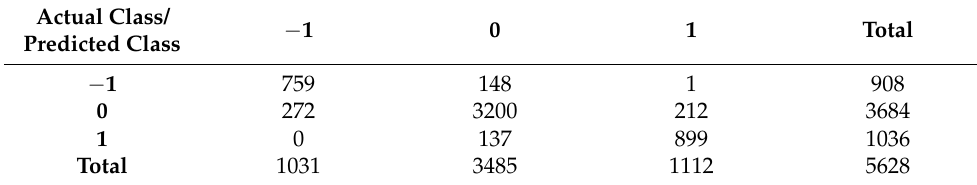
Table 5. Confusion matrix for all